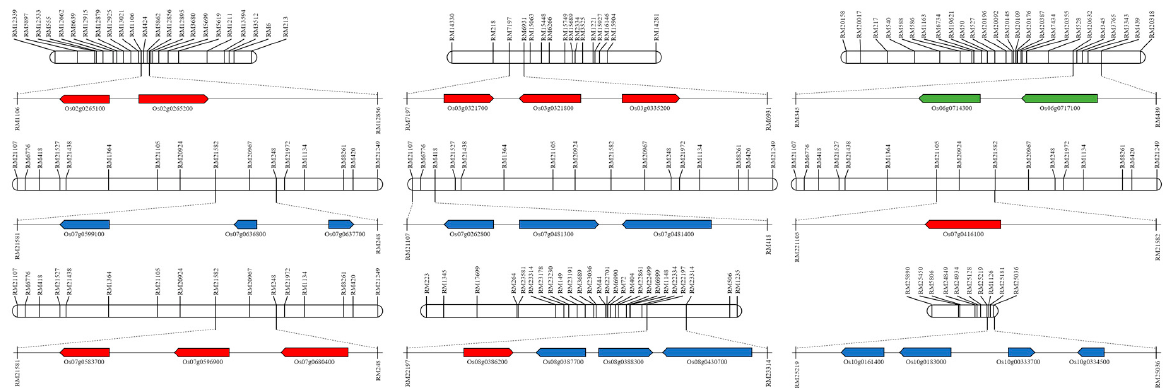
Figure 4. Physical map from the high-performance liquid chromatography data and the related quantitative trait locus (QTL) analysis using the Cheongcheong/Nagdong double haploid (CNDH) genetic map. Bacterial leaf blight resistance candidate genes around the marker area were screened based on the marker detected with an LOD score of 3.0 or higher. The chromosomal location of QTL was associated with the lesion length date of the CNDH genetic map. Red indicates the genes of the WRKY group; blue indicates disease resistance and plant defense group; green indicates the hormone signaling group.